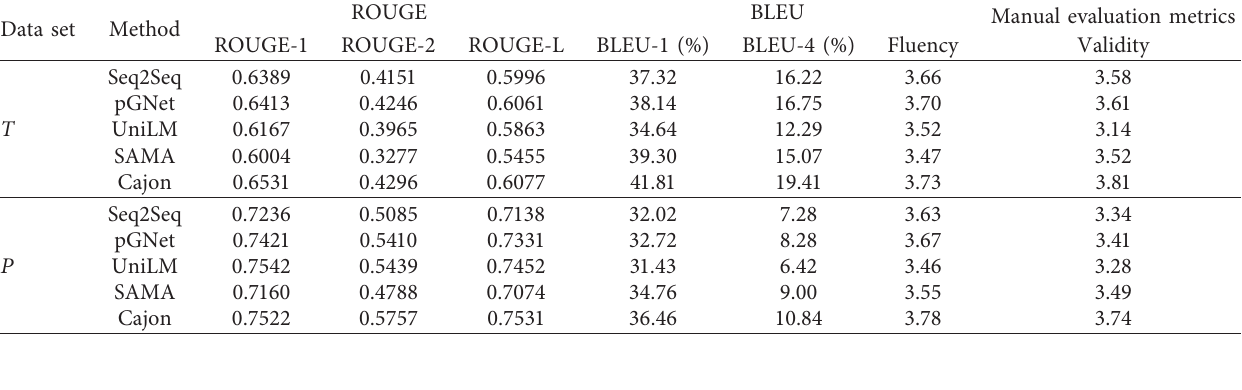
Table 2: Experimental results of Cajon and comparison methods.